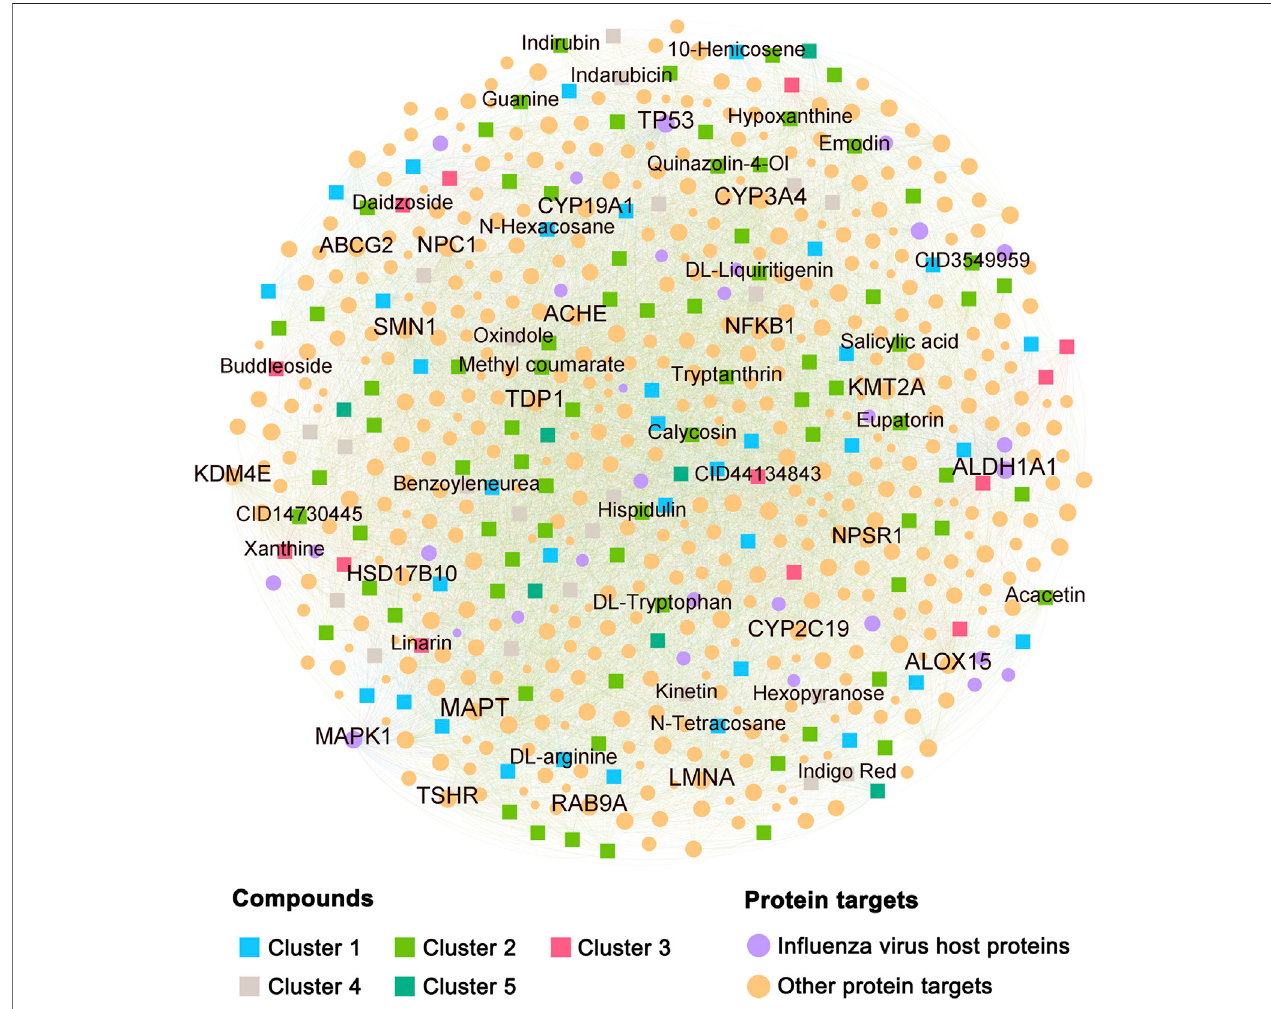
FIGURE 3 | Compound – target (C – T) network for 154 candidates derived from Isatis tinctoria L. (BLG). The font size of the label and node is proportional to the degree(connectivity)oftheitem. Squares and spots inthenetworkrepresentthecompoundsandproteintargets,respectively.Compoundswereclassi fi edaccordingto chemical scaffold clustering analysis and displayed in different colors . Labels of the top 20 protein targets with the highest degree and compounds possessing at least fi ve in fl uenza virus host protein targets are displayed.